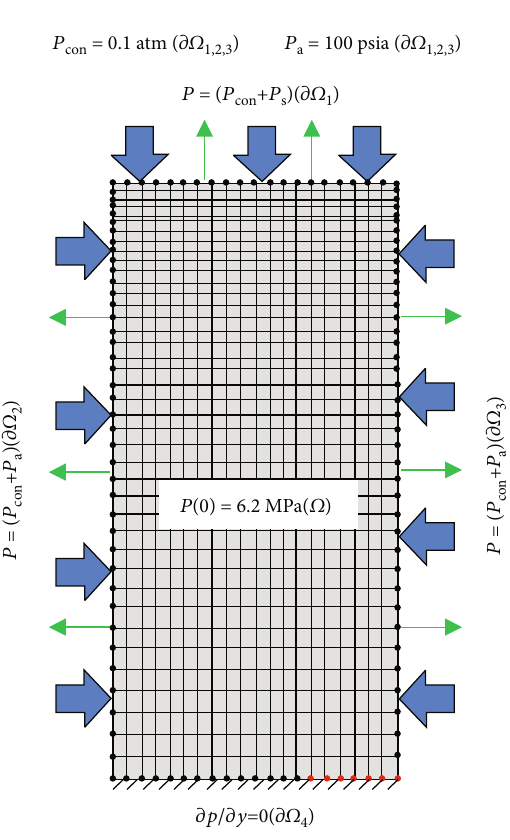
Figure 4: Schematic diagram of boundary and initial